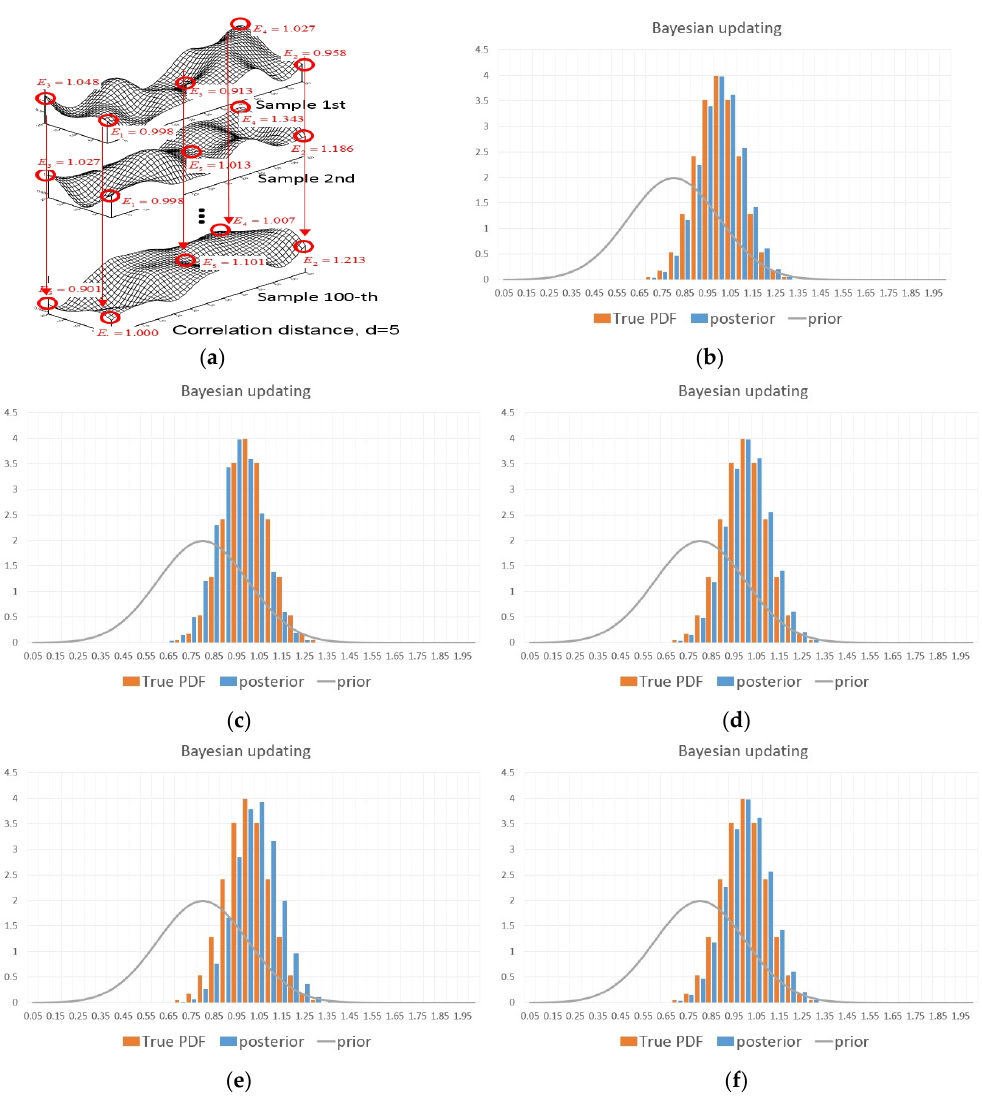
Figure 9. Bayesian updating at the stochastic field of the correlation distance d = 5.0: ( a ) How to perform Bayesian updating; ( b ) Observation point 1; ( c ) Observation point 2; ( d ) Observation point 3; ( e ) Observation point 4; ( f ) Observation point 5.